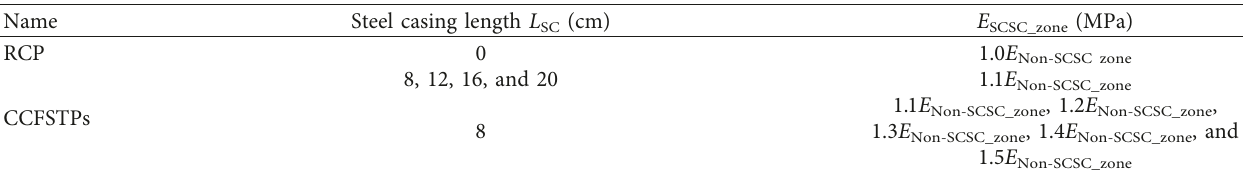
Figure 3: Schematic diagram of the soil compaction mould (unit: cm). Table 2: Test conditions.